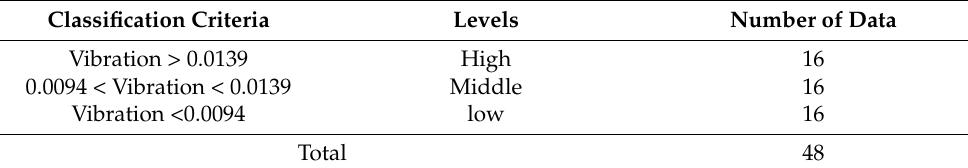
Table 12. Vibration dataset classification criteria.